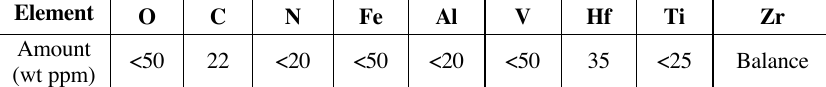
Table 1. Analysis of chemical composition of Zr material studied, from[7].